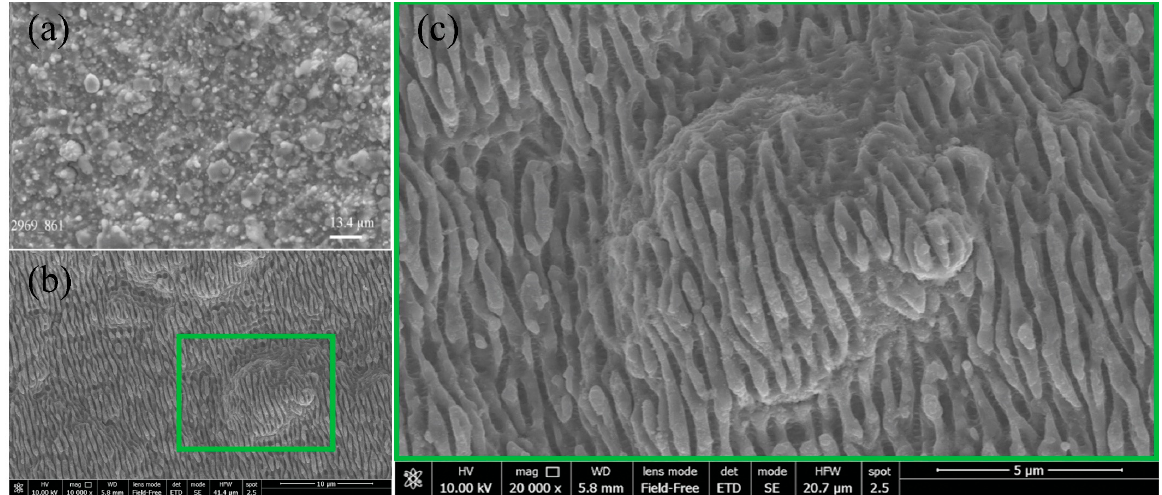
Figure 2. SEM observation of the surface of Ti/Fe ( a ) after vacuum arc condensation and after LIPSS formation on their surface ( b ) and its magnified view ( с ).